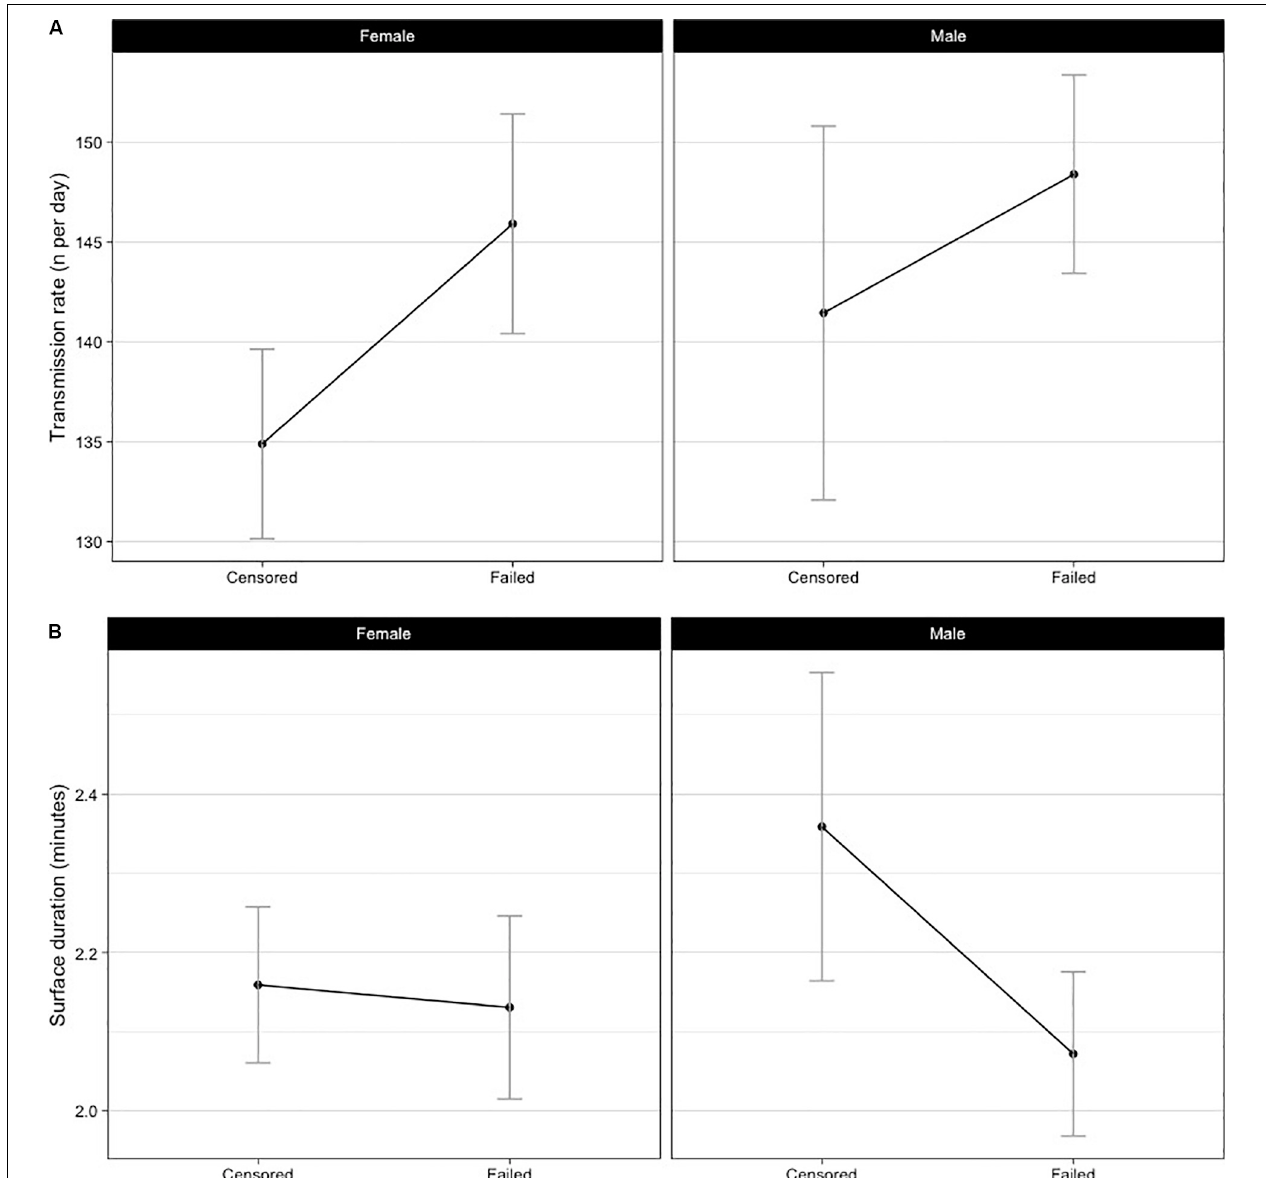
FIGURE 2 | Sex and outcome ( failed or censored ) specific mean daily transmission rates (A) and surface durations (B) . Failed tags had more transmissions per day (d.f. = 169, p = 0.003), but there were no differences in the surface durations (d.f. = 169, p = 0.5502).